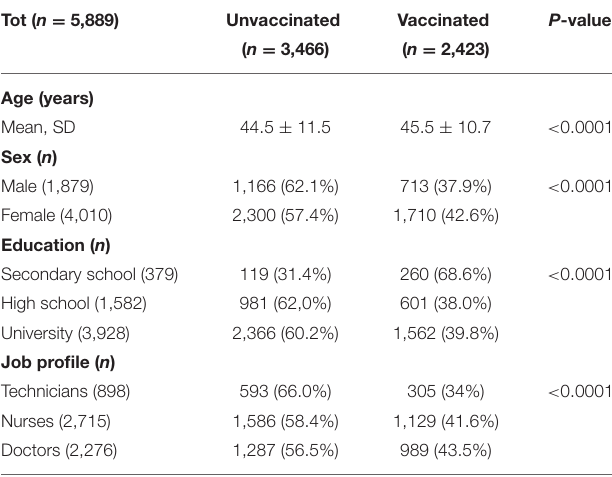
TABLE 1 | Demographic and occupational